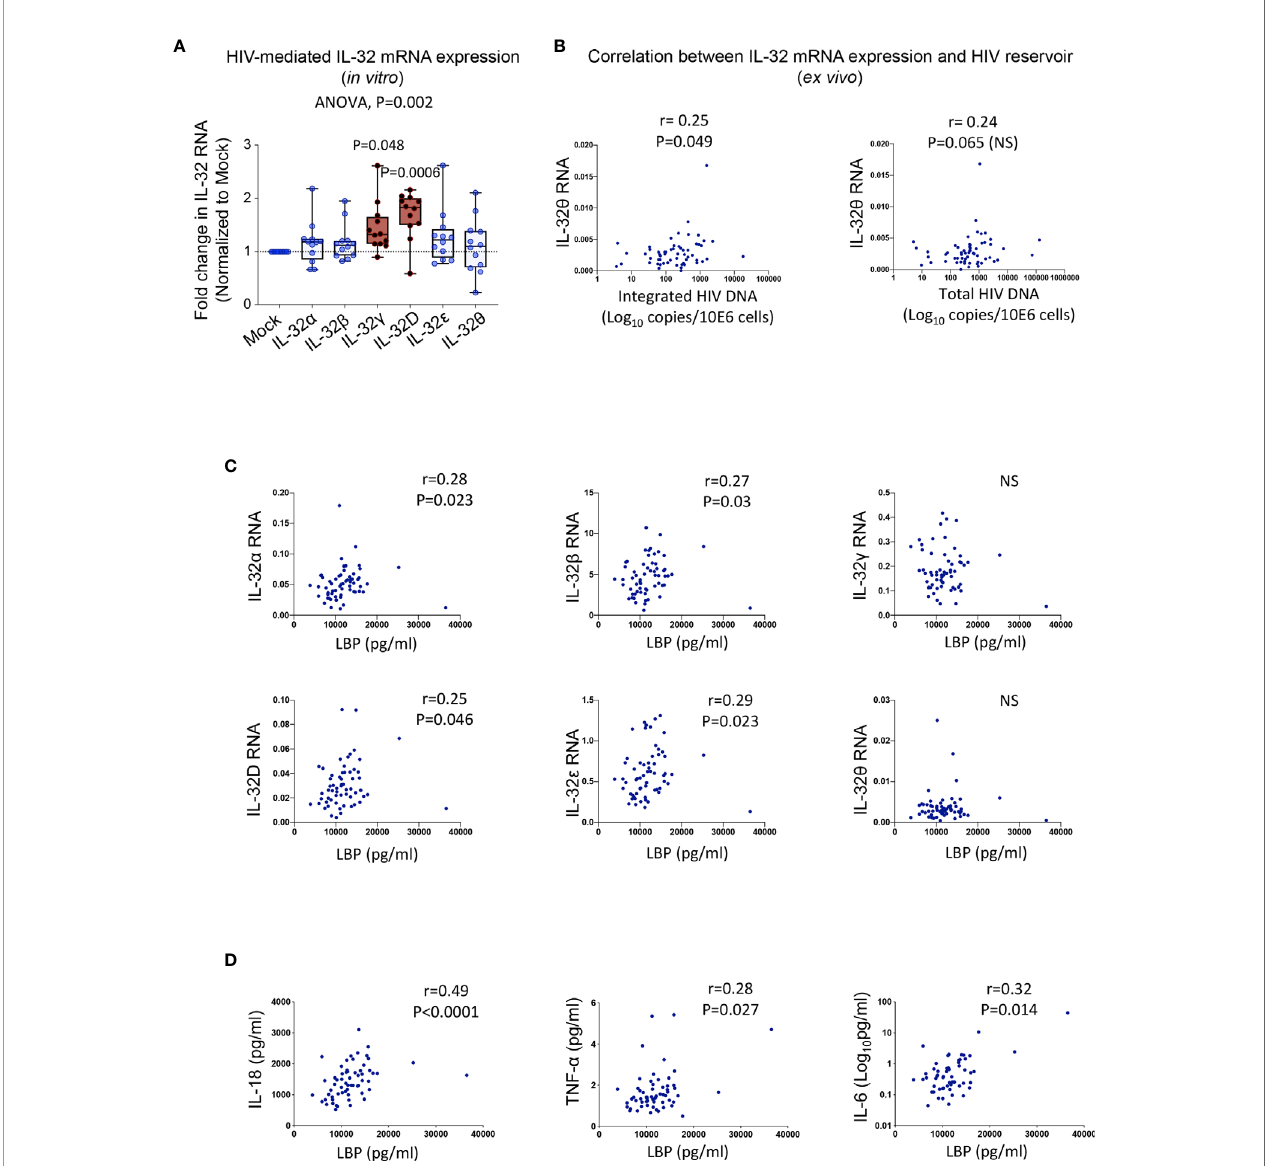
FIGURE 4 | Potential inducers of IL-32 in HIV infection. (A) Box-whiskers plot (min-max) for expression of IL-32 isoforms a , b , g , D, ϵ and q (measured by RT-qPCR and normalized to the housekeeping gene b -glucuronidase) in non-stimulated PBMCs isolated from healthy donors (n=12) and exposed to the dual tropic (X4/R5) HIV clone p89.6 for 6h. (B) Correlation between IL-32 q isoform and levels of integrated HIV DNA (left panel) and total HIV DNA (right panel) measured in primary CD4+ T-cells isolated from ART-treated HIV+ individuals with or without subclinical atherosclerosis (n=59) and expressed as Log 10 copies per million cells. (C) Correlations between plasmatic LBP levels and cell-associated IL-32 isoform RNA from n=61 HIV+ individuals. (D) Correlations between LBP and IL-18 (Left panel), TNF- a (middle panel) and IL-6 (right panel) from the same individuals as in (C) . Data analyzed with ordinary one-way ANOVA and Dunnetts ’ s multiple comparison in (A) and non-parametric Spearman correlations in (B – D) . NS, non-signi fi